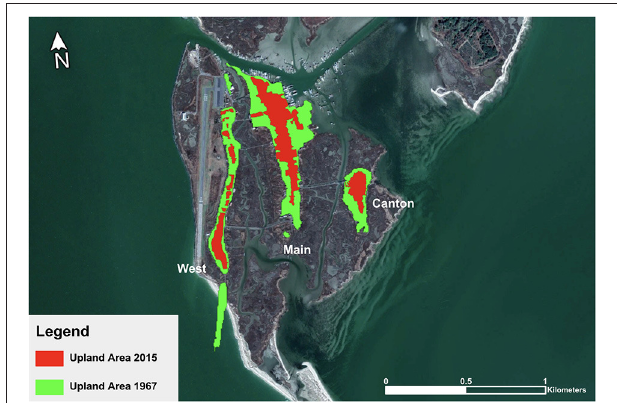
FIGURE 2 | The three upland ridges of the Town of Tangier’s upland area in 1967–2015 visualizing the extent of conversion. Map created using Esri ArcGIS, ArcMap 10.8. Source: USDA Farm Service Agency. Area found within the red rectangle of Figure 1 .